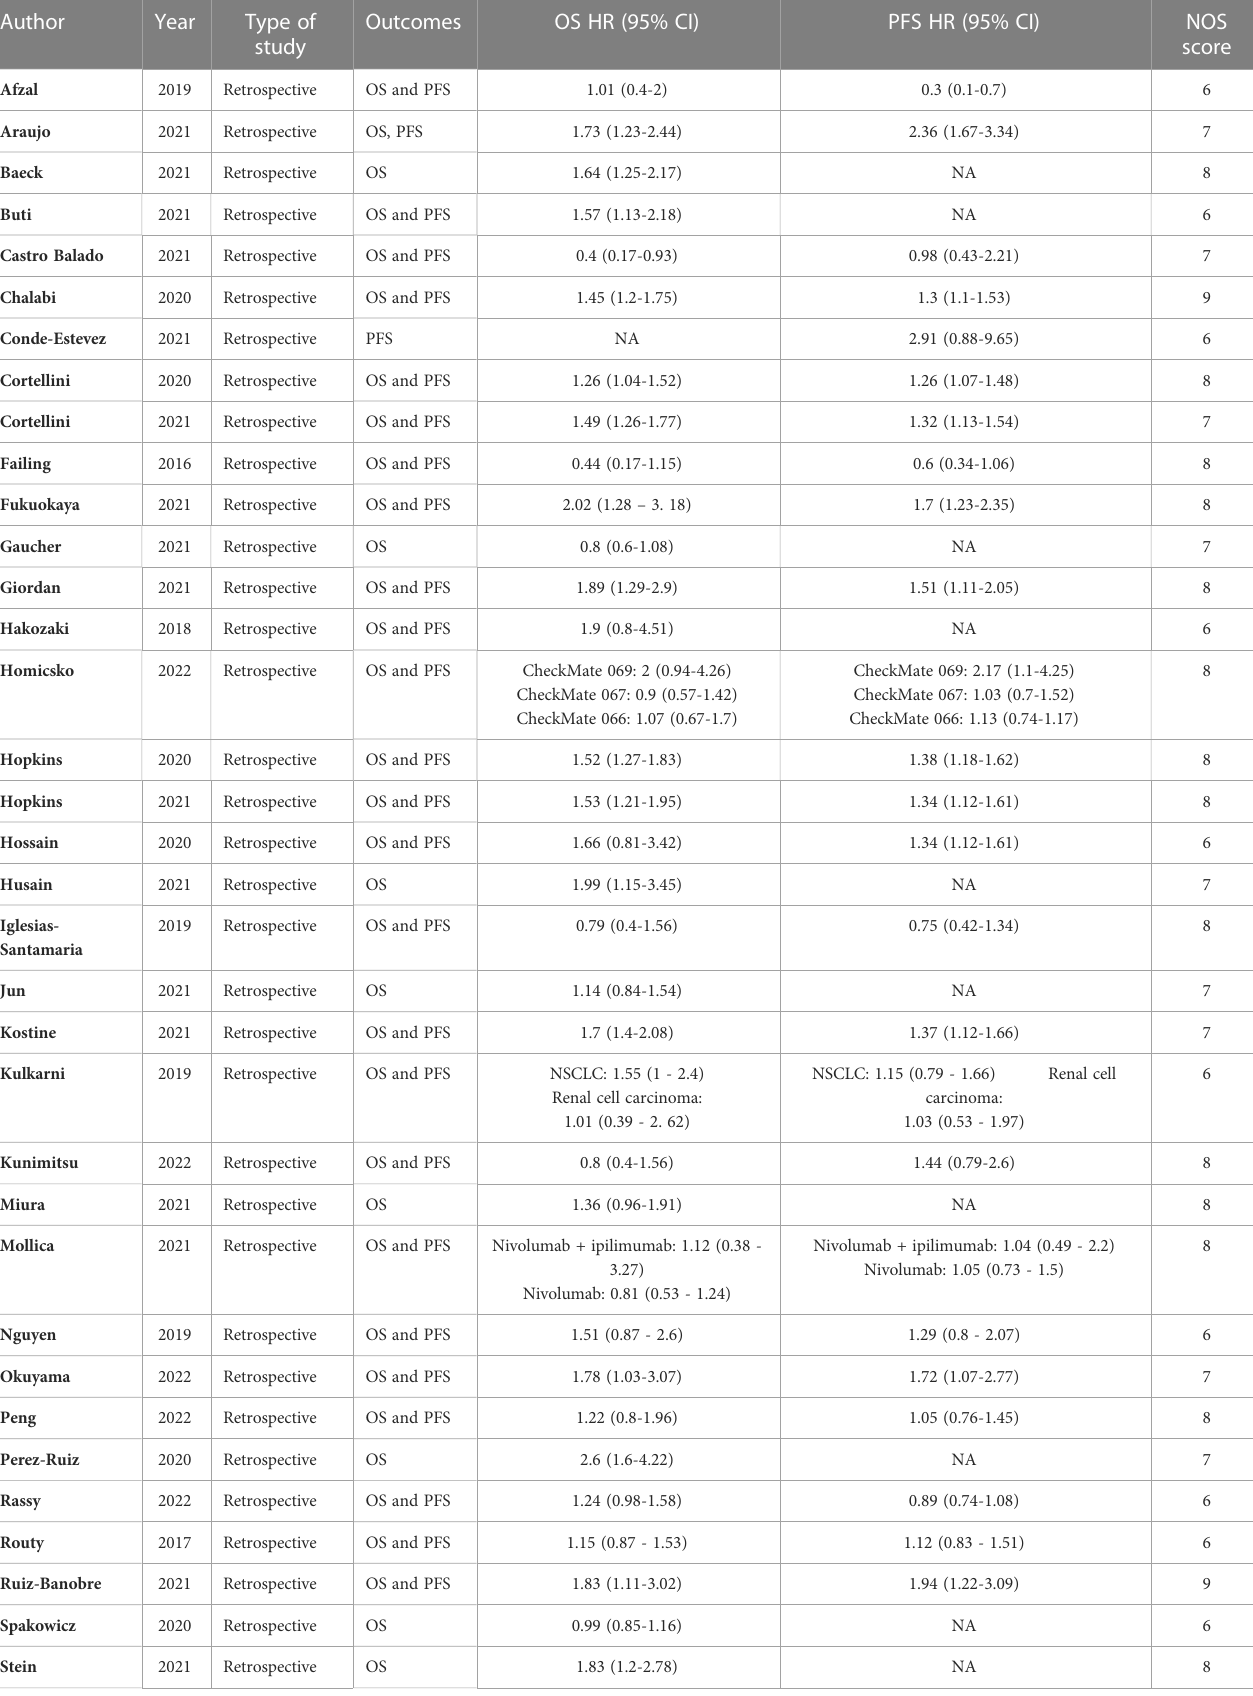
TABLE 2 Outcomes data and NOS score of included publications.